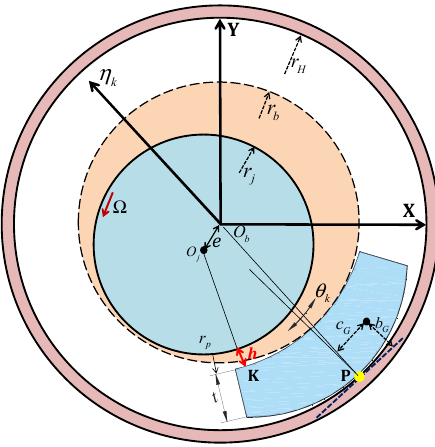
Figure 1. Schematic of a TPJB with one single pad.